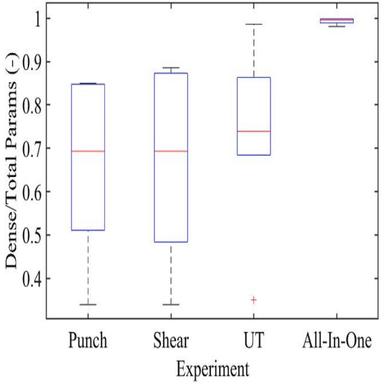
Mean and variance of the dense layer parameters to the total number of modeling parameters for the 15 highest validation score runs for the punch, shear, UT, and All-In-One experimental setups.